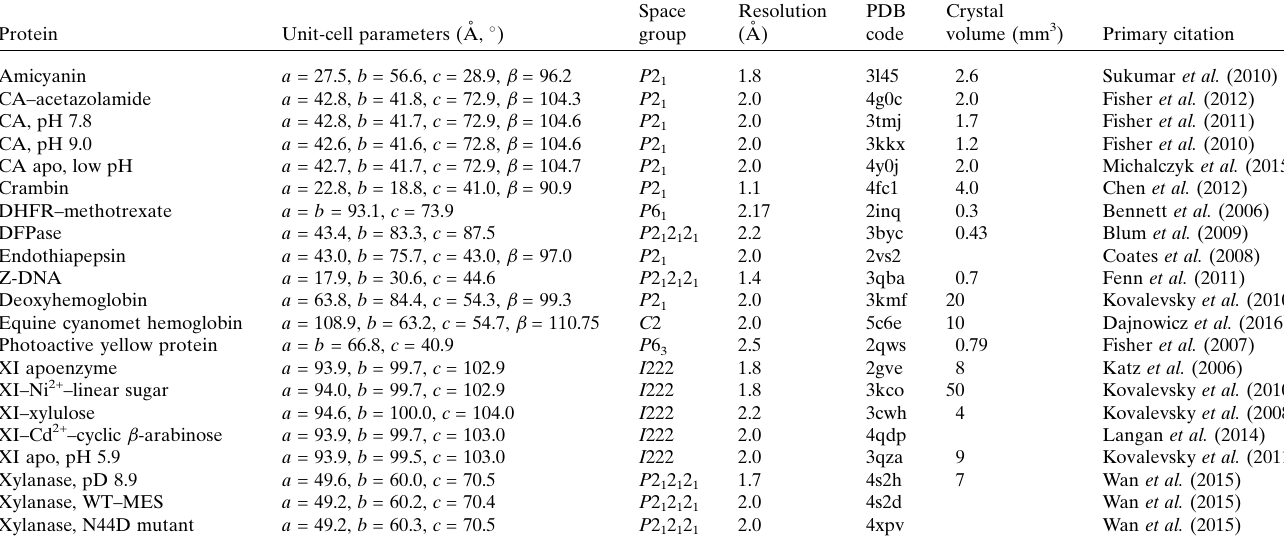
Table 2 Structures in the PDB collected at the PCS.